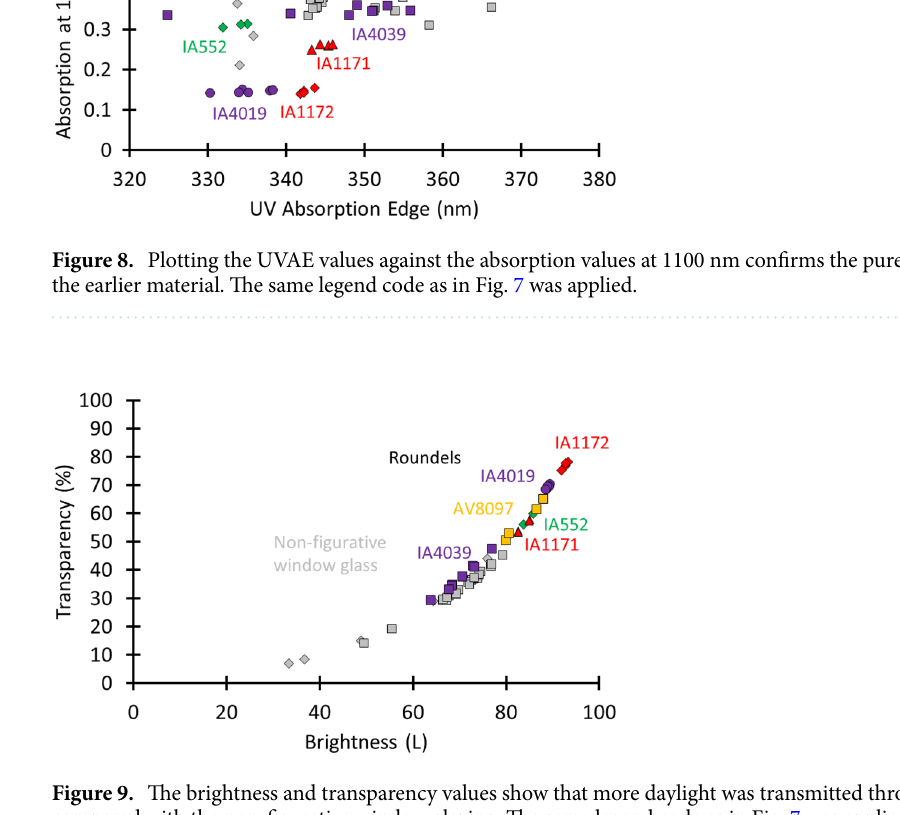
which both originate from the same region (Leuven), prove that the difference in glass purity is not caused by the geographical location of the workshop but rather to a chronological difference in applied production technique. At first sight, roundel IA1171 appears to be an outlier. Based on its stylistic properties, this roundel was classified in the second half of the sixteenth century, while its glass purity matches with that of the later non-figurative window material. It is an open question if this roundel was painted on a bare glass sheet that was still in stock from an earlier date or if the glass purity transition point for roundel material must be situated at the end of the sixteenth century. Another observation is that every optical parameter, measured at different locations within one roundel, leads to a specific cluster and that the different clusters do not overlap. Another remarkable notice is that for each of the earlier defined non-figurative window groups, a roundel was found for which the colour values, the absorption at 1100 nm and the UVAE values, overlap. These are roundel IA552 for the lozenge group and roundel IA4039 for the quadrangular group. Finally, we studied the daylight transmission of these roundels (Fig. 9) and concluded that more daylight was transmitted through the roundels compared with the non-figurative window glazing. This is with the exception of roundel IA4039. The higher absorption might stem from the grisaille layer. The higher light transmission of the roundels might reflect their social status (i.e., roundels were considered to be luxurious materials). A sec- ond conclusion is that in contrast to the non-figurative window material, the purer roundel material resulted in the highest daylight transmission, which originates from similar glass thicknesses (Supplementary Table S4). This is seen in Fig. 9, where the transparency and brightness values of roundels IA1172 and IA4019 are higher compared with those of roundel AV8097. For this last roundel, it was noticed that despite its less pure material character, transparency values could be obtained that are comparable to those of roundels produced with much purer materials (roundels IA552 and IA1171). The reason for this can be ascribed to its lesser thickness (Sup- plementary Table S4). We remark that this roundel might originate from the Northern Low Countries. After the ‘Fall of Antwerp’ in 1585, the Low Countries were more or less divided into the Protestant Northern Netherlands and Catholic Southern Netherlands. In the sixteenth century, most roundels were executed on cylinder glass, but it is reported in the literature that especially in the Northern Netherlands, crown glass made a comeback by the